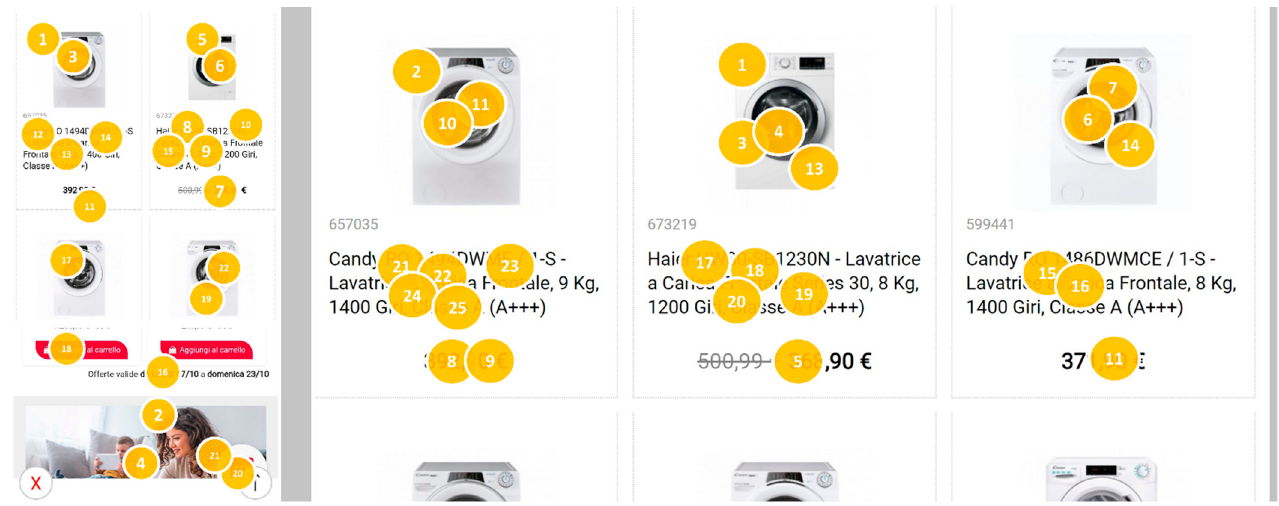
Figure 9. Comparison between the gaze heatmaps of two users who performed the test on a mobile device ( left ) and on a desktop ( right ). The numbers represent the order in which the coordinates were recorded.